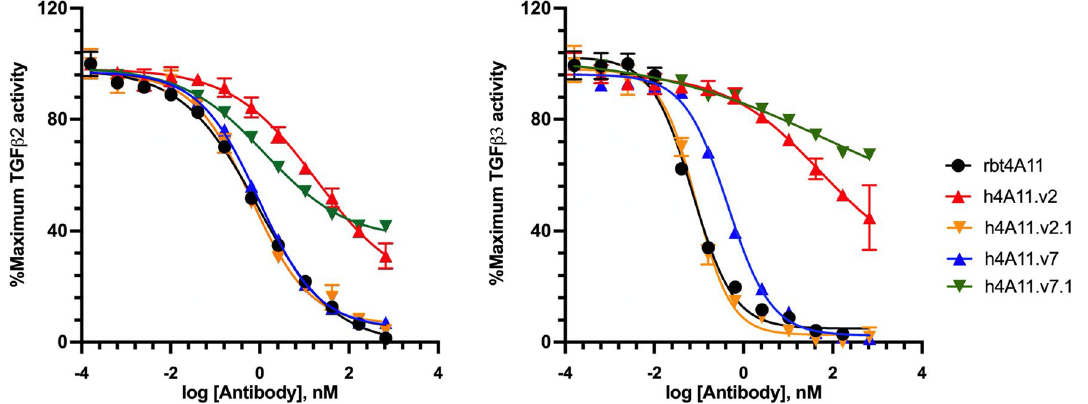
Figure 5. Dose-dependent inhibition of TGFβ by humanized 4A11 variants in HEK Blue™ TGFβ reporter cell-based assay. Human mature TGFβ2 (left) or TGFβ3 (right) isoform was incubated with a serial dilution of humanized 4A11 variants in quadruplicate to generate a dose-dependent inhibition curve. The response was normalized to maximum TGFβ activity (%) and mean activity ± standard deviation was plotted as a function of antibody concentration. The variants exhibiting less than 10% of maximum TGFβ activity at the highest antibody concentration were complete blocker (e.g., rbt4A11, h4A11.v2.1, h4A11.v7), whereas those reaching greater than 30% of maximum TGFβ activity were incomplete blockers (e.g., h4A11.v2,